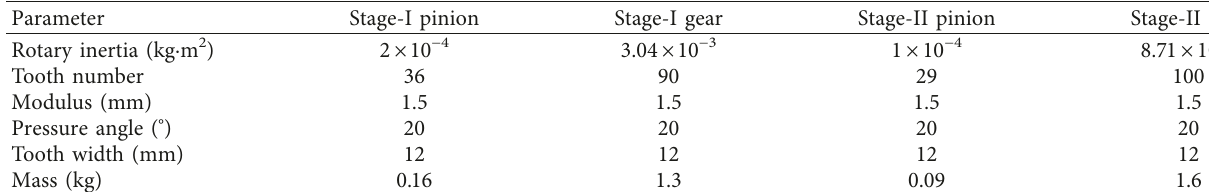
Table 2: Parameters of the gear.